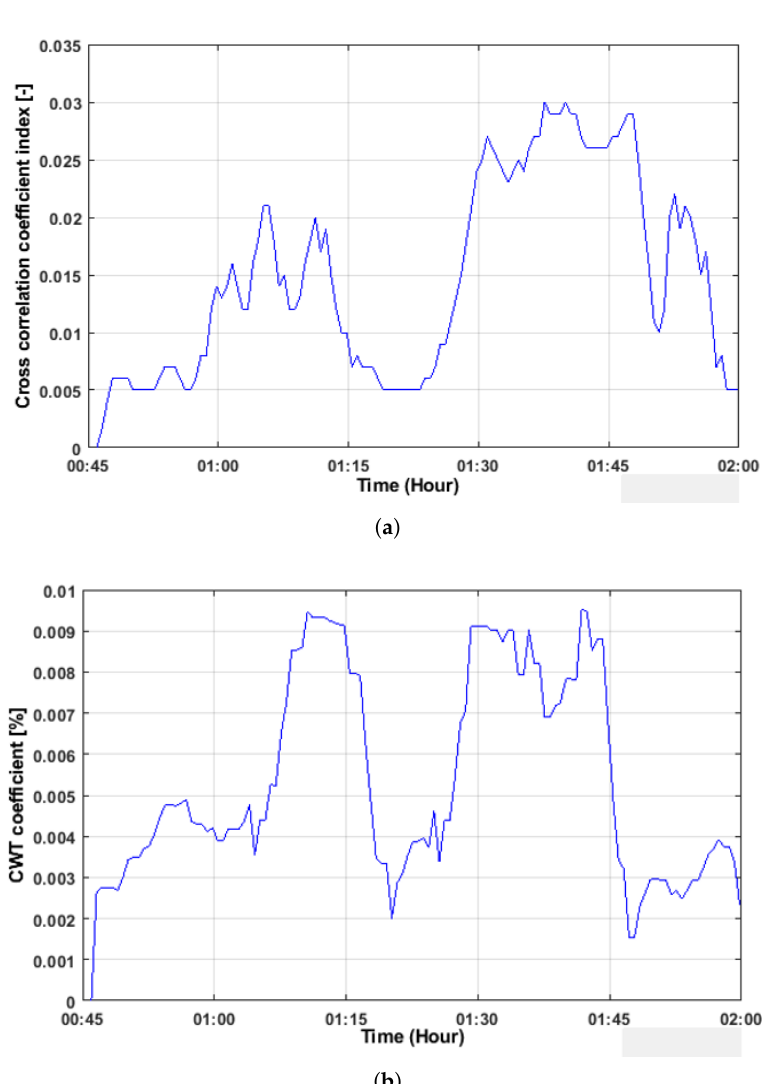
Figure 13. Values of both coefficient indices. ( a ) Cross-correlation coefficient index from the sensor pair S01R02 in the Gliwice bridge; ( b ) CWT coefficient index from the sensor pair S01R02 in the Gliwice